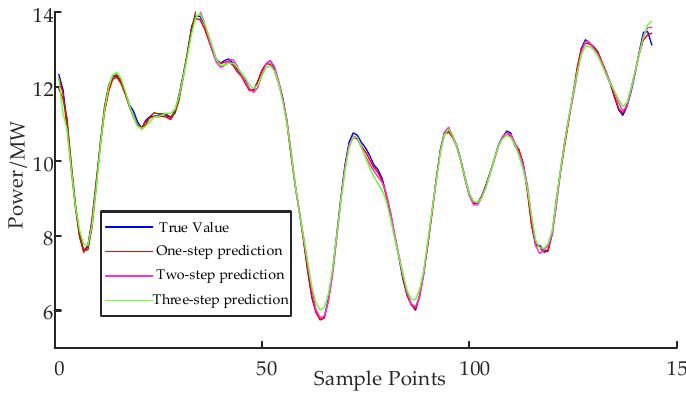
Figure 7. Modified one-two-three-step predictive value. Table 5. Error evaluation indexes of each prediction model.